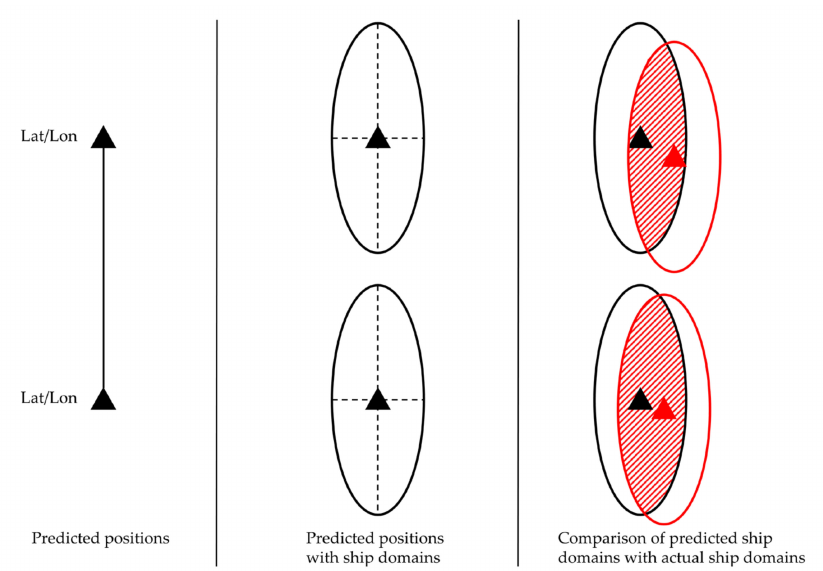
Figure 5. Evaluation of prediction performance using Fujii’s ship domain.